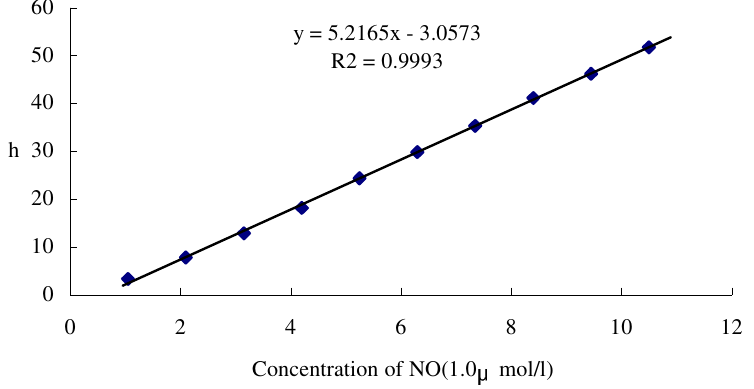
Fig. 5 . Relationship between NO concentration • 10 -6 mol/l — 10 -5 mol/l • in seawater and